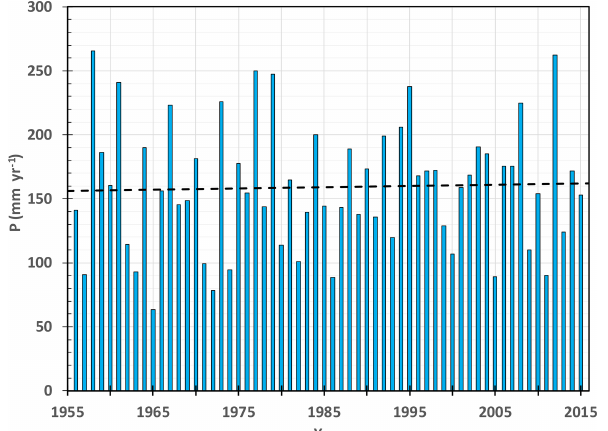
Figure 5. Areal-averaged annual precipitation of the Hetao Basin, 1957 to 2013. The linear trend is not significant.